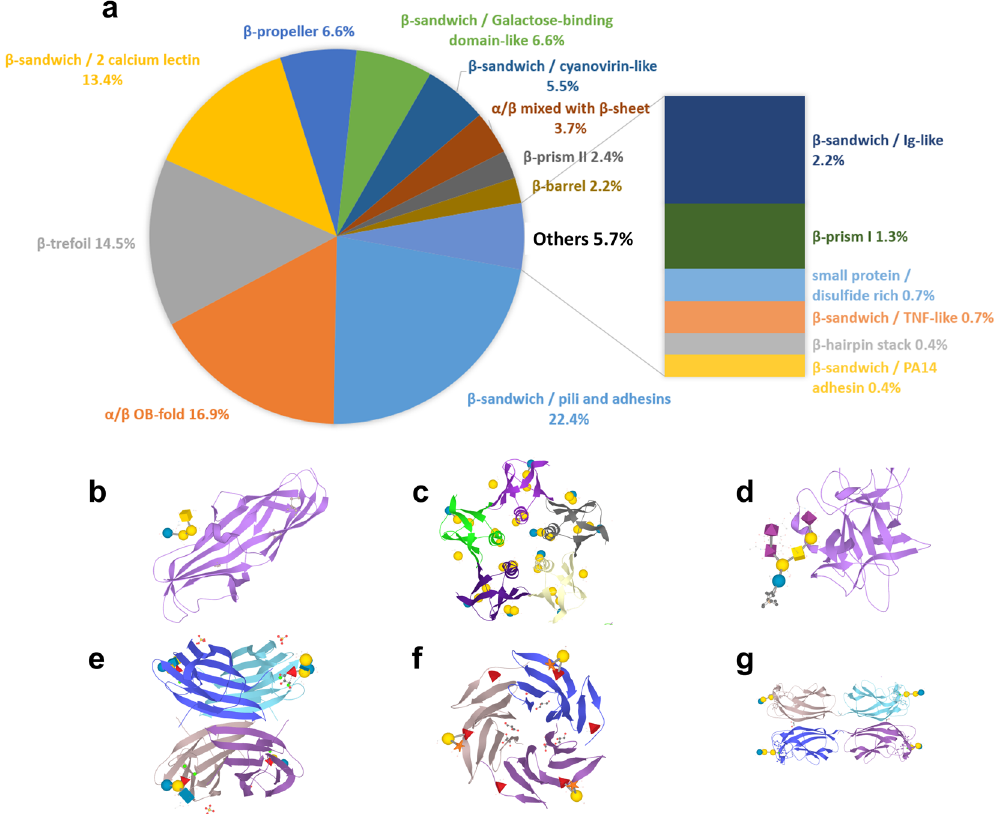
Fig. 1 Bacterial lectin folds. a Distribution of bacterial lectin folds derived from the UniLectin3D database. From the analysis of fold distribution of bacterial lectin crystal structures, the six most frequent folds are detailed. b β -Sandwich/pili and adhesins fold representative: Escherichia coli PapG in complex with GalNAc( β 1-3)Gal( α 1-4)Gal( β 1-4)Glc (PDB code 1J8R); c α / β OB fold: E. coli SLT-1 with Gal( α 1-4)Gal( β 1-4)Glc (1BOS); d β -Trefoil fold: Clostridium tetani TeNT with GT1b ganglioside NeuAc( α 2-3)Gal( β 1-3)GalNAc( β 1-4)[NeuAc( α 2-8)NeuAc( α 2-3)]Gal( β 1-4)Glc (1FV2); e β -Sandwich/2 calcium lectin fold: Pseudomonas aeruginosa LecB with Gal( β 1-4)GlcNAc( β 1-3)Gal( β 1-4)[Fuc( α 1-3)]Glc (1W8F); f β -Propeller fold: Ralstonia solanacearum RSL with Fuc( α 1-2)Gal( β 1-2)Xyl (2BS6); and g β -Sandwich with galactose-binding domain-like fold: P. aeruginosa LecA/Gal( α 1-3)Gal( β 1-4)Glc (2VXJ). 3D structures were generated using LiteMol 85 with terminal monosaccharides at binding sites represented using Symbol Nomenclature for Glycans (SNFG) 86